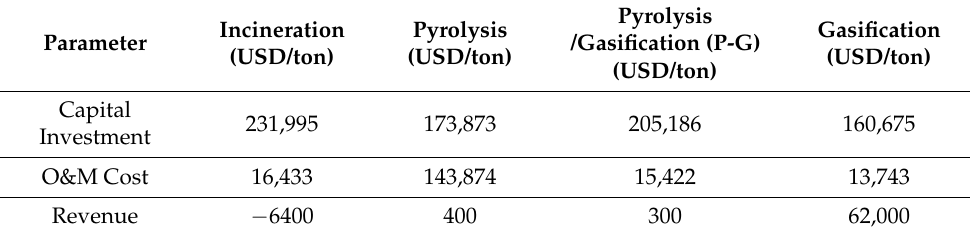
Table 4. Economic analysis of MSW treatment methods in USD/ton of MSW feedstock